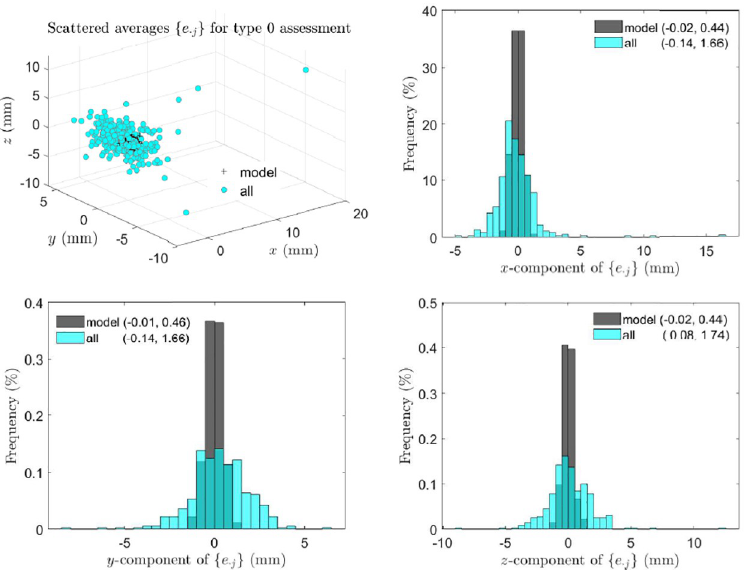
Fig 9. Type 0 assessment: Directional asymmetry of skulls. Scattered points and histograms of asymmetry indices of the 359 perturbed symmetric skull and all real skulls are shown, where in brackets are the the means and the standard deviations of components of { e � j }.